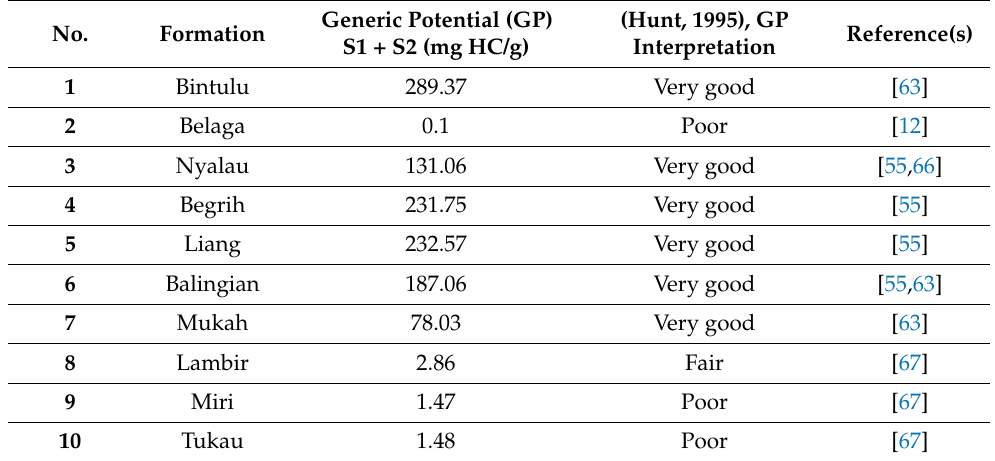
Table 16. Interpretation of average GP values of formations in Sarawak according to Hunt